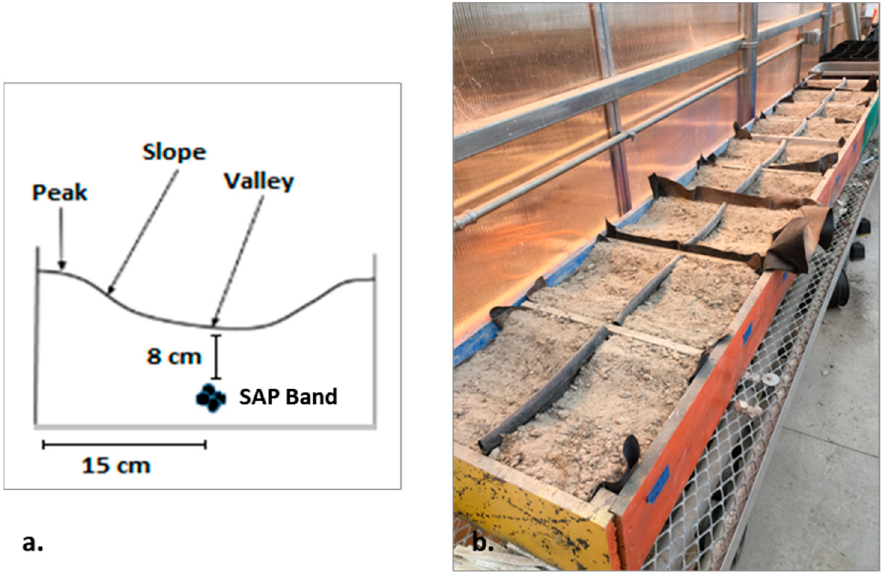
Figure 1. Frontal cross section diagram ( a ) of a grow box unit ( b ) containing soil with a superabsorbent polymer (SAP) band 8 cm below the soil surface of the furrow valley.